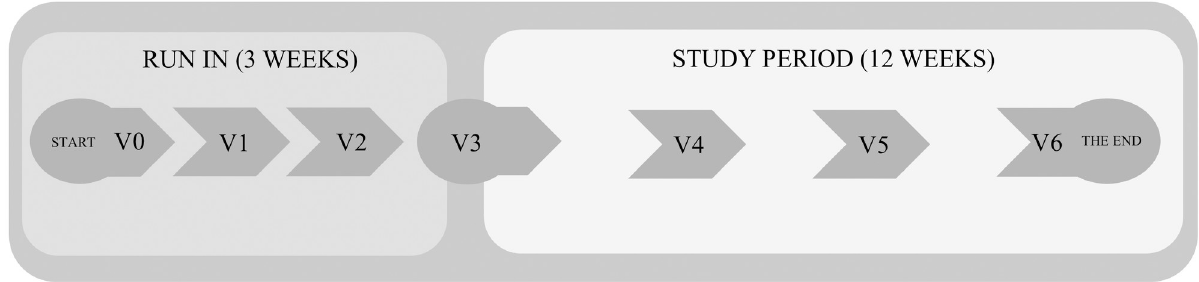
Fig 2. Flow diagram—Study design. Run-in visits were performed every 1 week and study period visits every 4